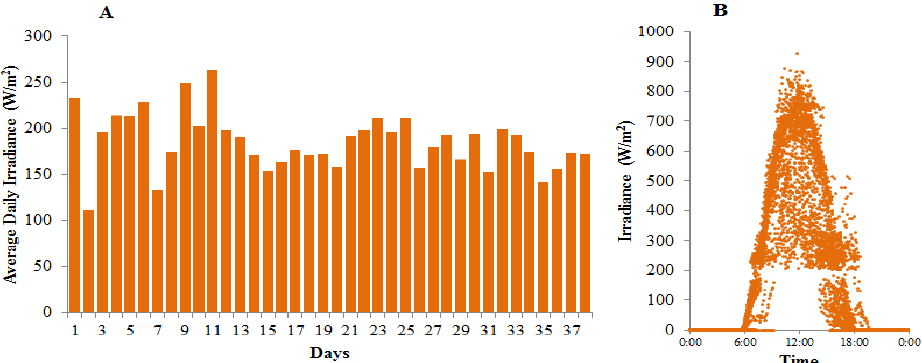
Figure 2. Daily averages ( A ) and oscillations ( B ) of aerial solar irradiance during observation time.